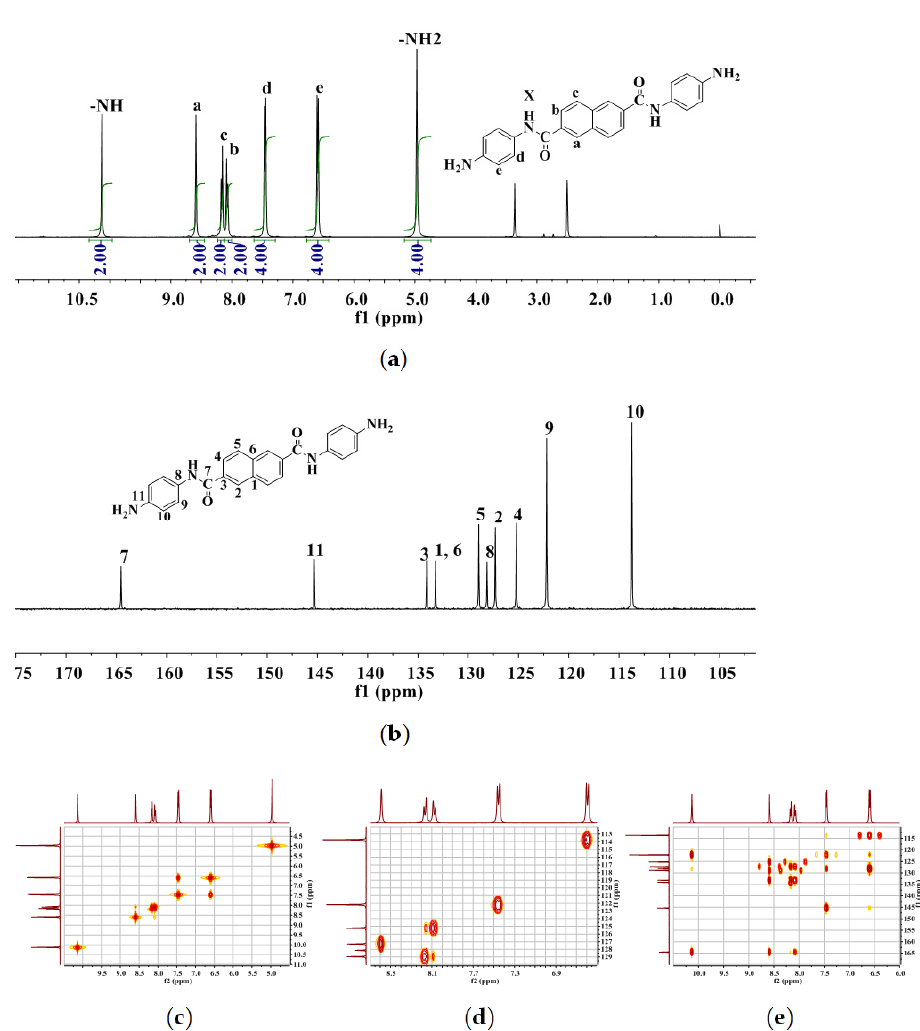
Figure 3. ( a ) 1 H Chemical Shifts, f1 (ppm) in 1 H NMR, ( b ) 13 C Chemical Shifts, f1 (ppm) in 13 C